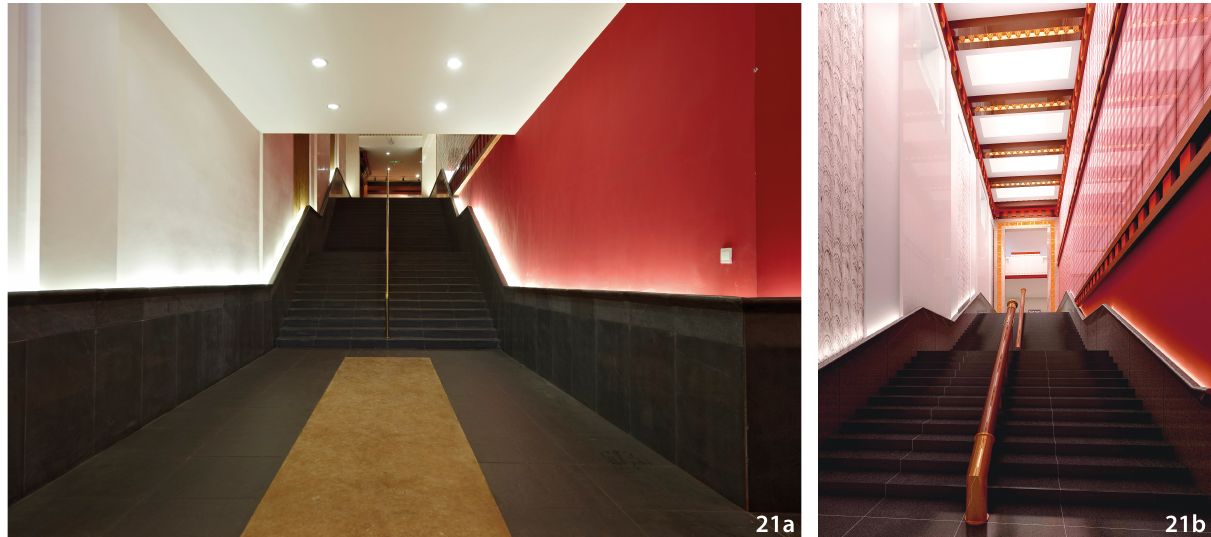
Figure 21a The hall in the Sangzhutse Fortress I (Source: Zhang Siye). Figure 21b The hall in the Sangzhutse Fortress II (Source: Zhang Siye).